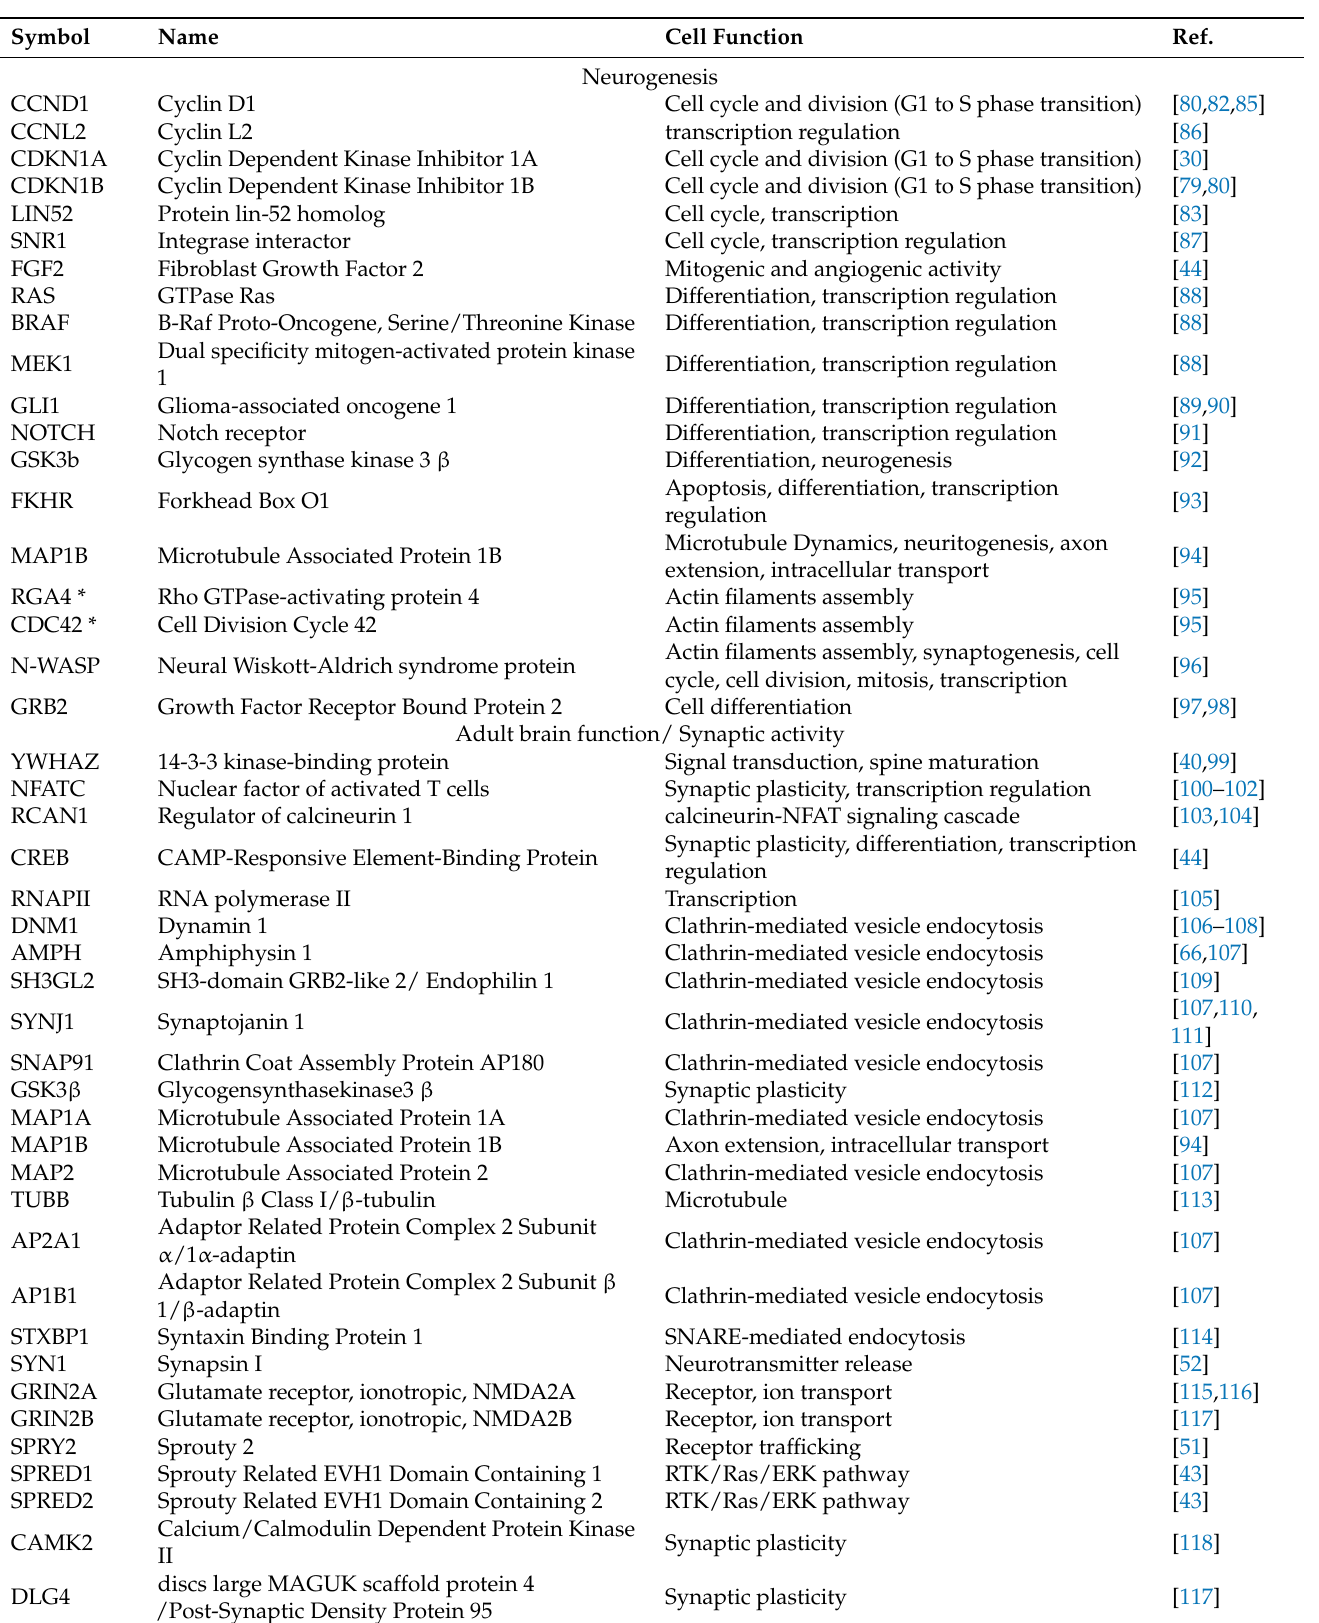
Table 2. Main DYRK1A interactors, partners and targets (* only described in